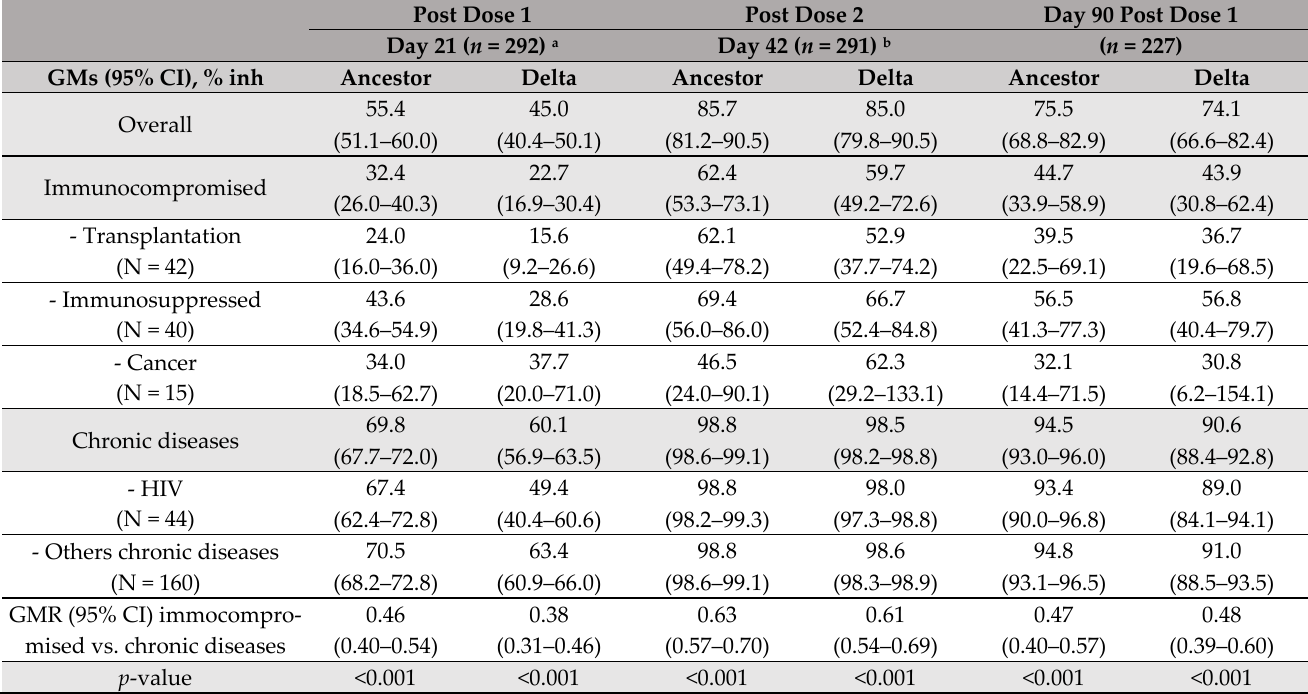
Table 2. Surrogate viral neutralizing titer (sVNT) against ancestor and Delta strains after BNT162b2 vaccination among adolescents with chronic diseases.